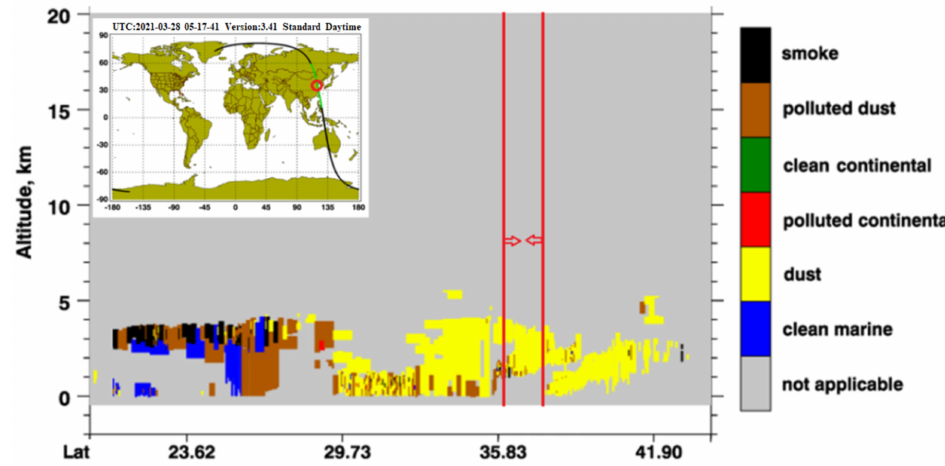
Figure 3. The vertical continuous detection by CALIPSO: aerosol subtypes on 28 March